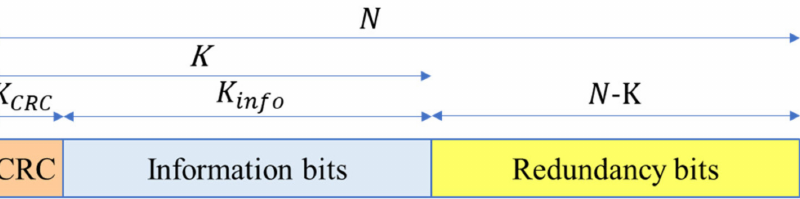
Figure 2. Polar code Frame after adding CRC